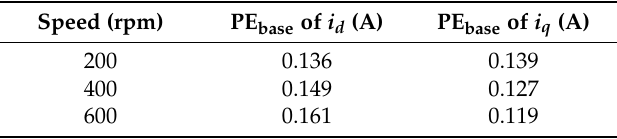
Table 2. PE base under different